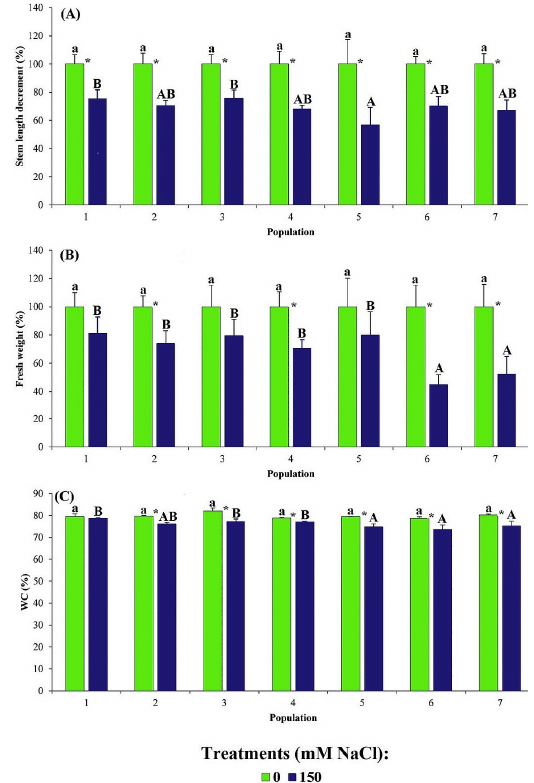
Fig. 2. Stress-induced inhibition of growth in Larix decidua after 30 days of treatments (150 mM NaCl and non-stressed controls). (A) Relative stem length reduction; (B) Relative fresh weight reduction; (C) Water content as a percentage of FW (WC%). Values shown are means ± SE (n = 5). Different letters (lower case for controls and capital letters for salt- stressed plants) in a column indicate significant differences between different populations according to Tukey test (α = 0.05). Asterisks (*) indicate significant differences between salt-treated and control seedlings of the same population. Populations are given number codes according to Table